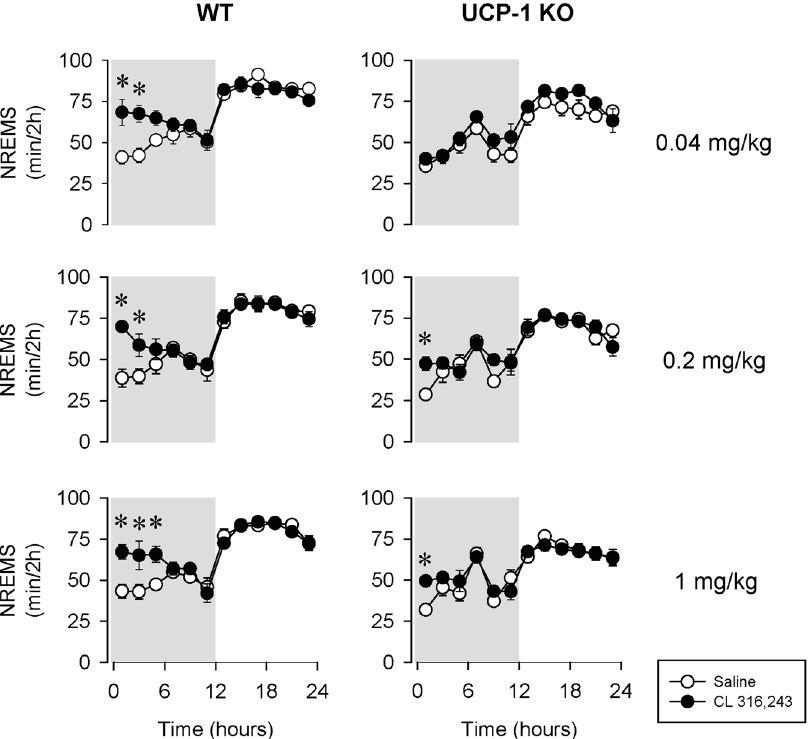
Figure 1. The effects of the selective β 3-adrenergic receptor ( β 3-AR) agonist CL-316,243 (black symbols) on non-rapid-eye movement sleep (NREMS) in wild-type (WT; left panels) and uncoupling protein-1 knockout (UCP-1 KO; right panels) mice. On the baseline day saline (open symbols) was administered subcutaneously 10–15 min before the onset of the dark phase. On the experimental day, one dose of CL-316,243 (0.04, 0.2 or 1 mg/kg; top, middle and bottom panels, respectively) was injected prior dark onset. Asterisk ( * ) denotes significant difference from baseline, p < 0.05. Error bars: standard error. Grey areas represent the dark